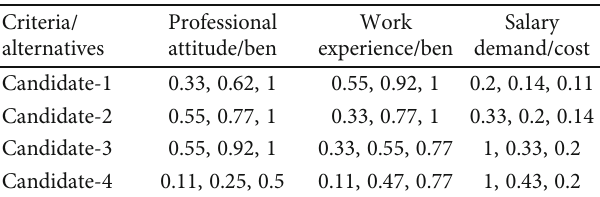
Table 4: Combined normalized decision matrix.